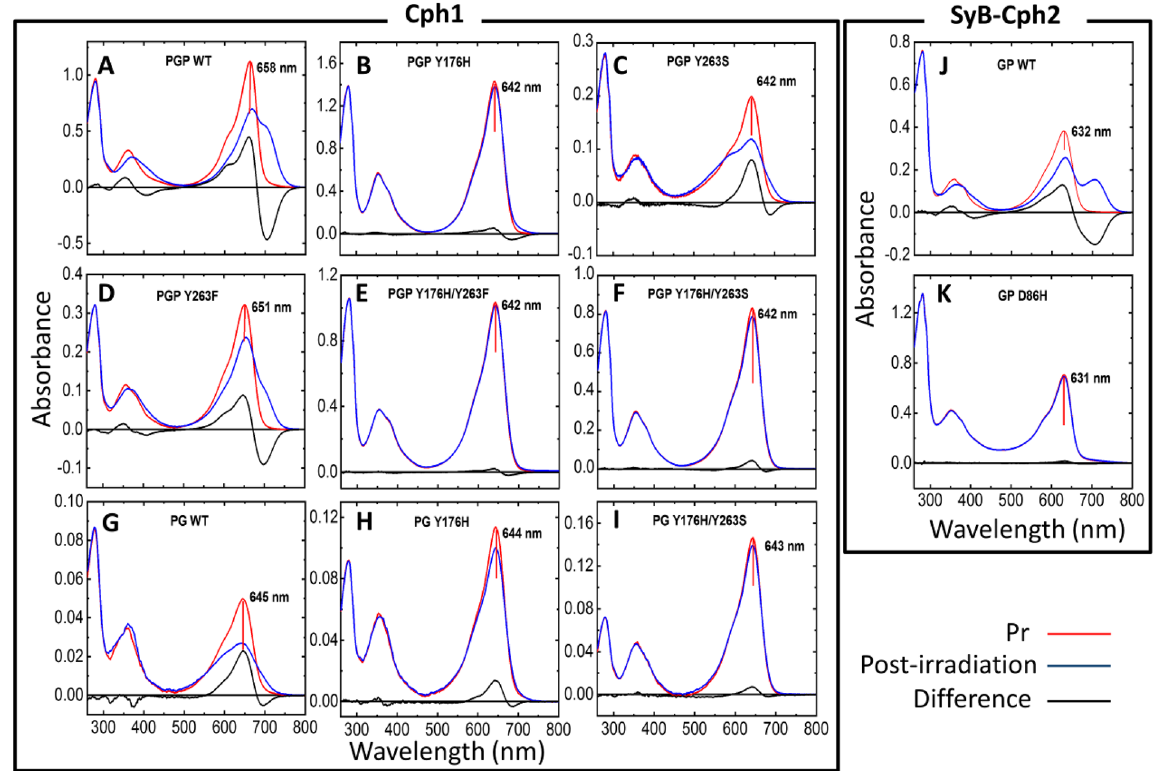
Figure 2. UV–vis absorption spectra of Cph1 PGP, Cph1 PG, SyB-Cph2 GP and variants. The dark-adapted (Pr state) and post-irradiation spectra (red light irradiated sample) are shown in red and blue, respectively. The difference spectra are shown in black. λ max values for Pr are indicated. Cph1 PGP WT and variants are shown in A to F, Cph1 PG WT and variants in G to I. SyB -Cph2 WT and its variant are shown in J and K. Buffer